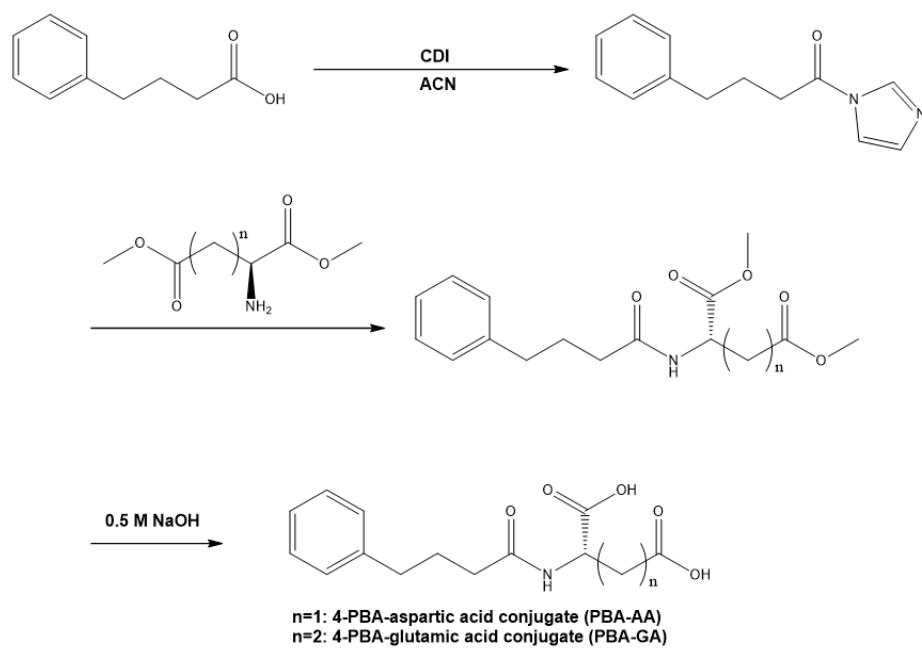
Figure 1. Scheme for the synthesis of N -(4-phenylbutanoyl) glutamic acid (PBA-GA) and N -(4- phenylbutanoyl) aspartic acid (PBA-AA). ACN: acetonitrile, CDI: 1,1 ′